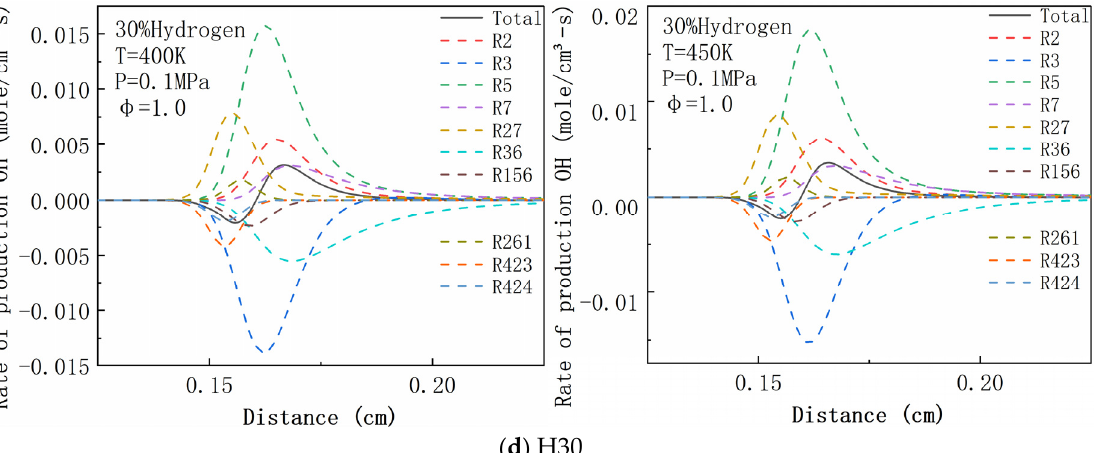
Figure 15. Rates of OH radical production for various fuels. Working conditions at ϕ = 1.0 and P = 1 bar: ( a ) Ethanol, ( b ) H10, ( c ) H20, and ( d ) H30; left: 400 K and right: 450 K.